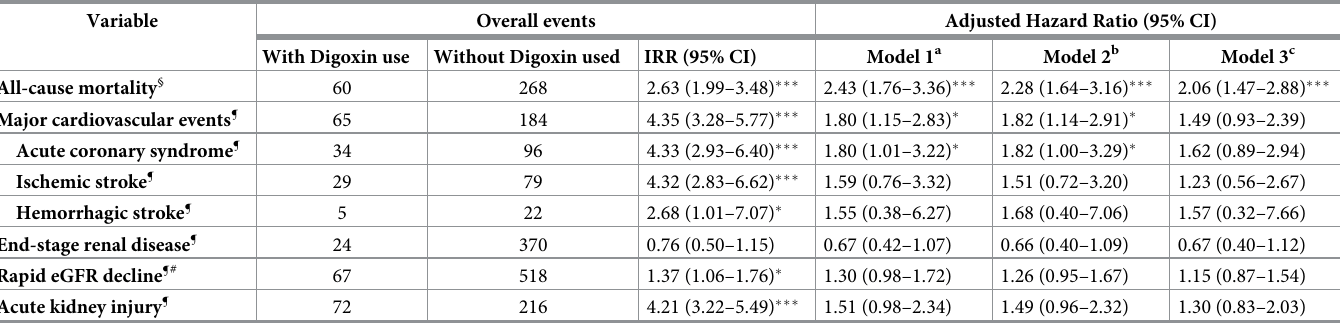
Table 3. Association between digoxin used or not and all-cause mortality, major cardiovascular events, and renal function decline in patients with chronic kidney disease using as treat analysis. Variable Overall events Adjusted Hazard Ratio (95% CI) With Digoxin use Without Digoxin used IRR (95% CI) Model 1 a Model 2 b Model 3